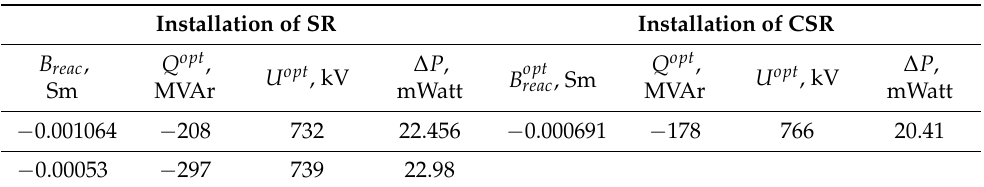
Table 8. Results of parametric optimization when using CSR and SR for transposed extra-high voltage power lines by with optimal steps.